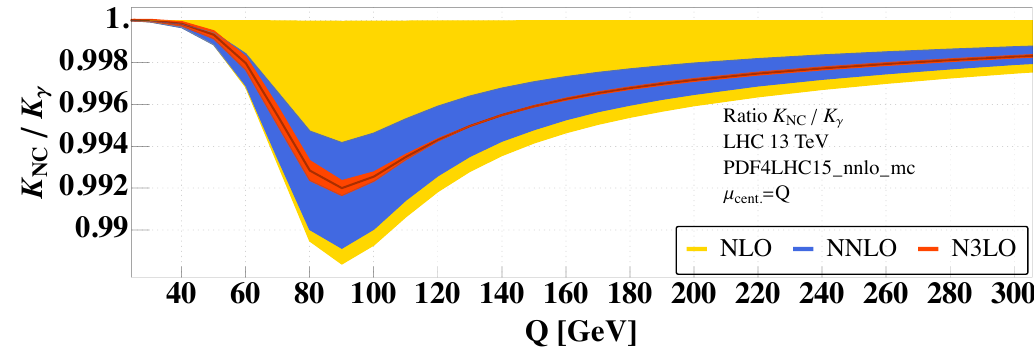
Figure 11. Ratio of the K-factors for NCDY and γ ∗ production as a function of Q 2 at different orders in perturbation